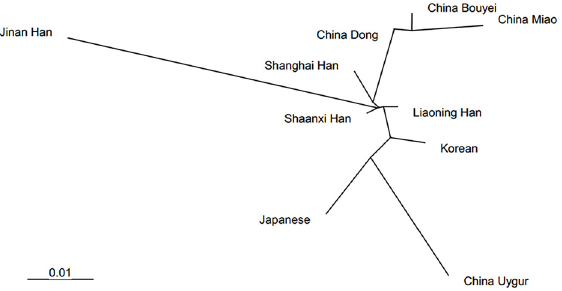
Fig 4. A phylogenetic tree showing the relationship between the Liaoning Han ethnic group and nine other populations. The tree was constructed using allele frequency data from 15 autosomal STR loci for all populations (Shananxi Han; Jinan Han; Shanghai Han; China Dong; China Bouyei; China Miao; China Uygur; Japanese;